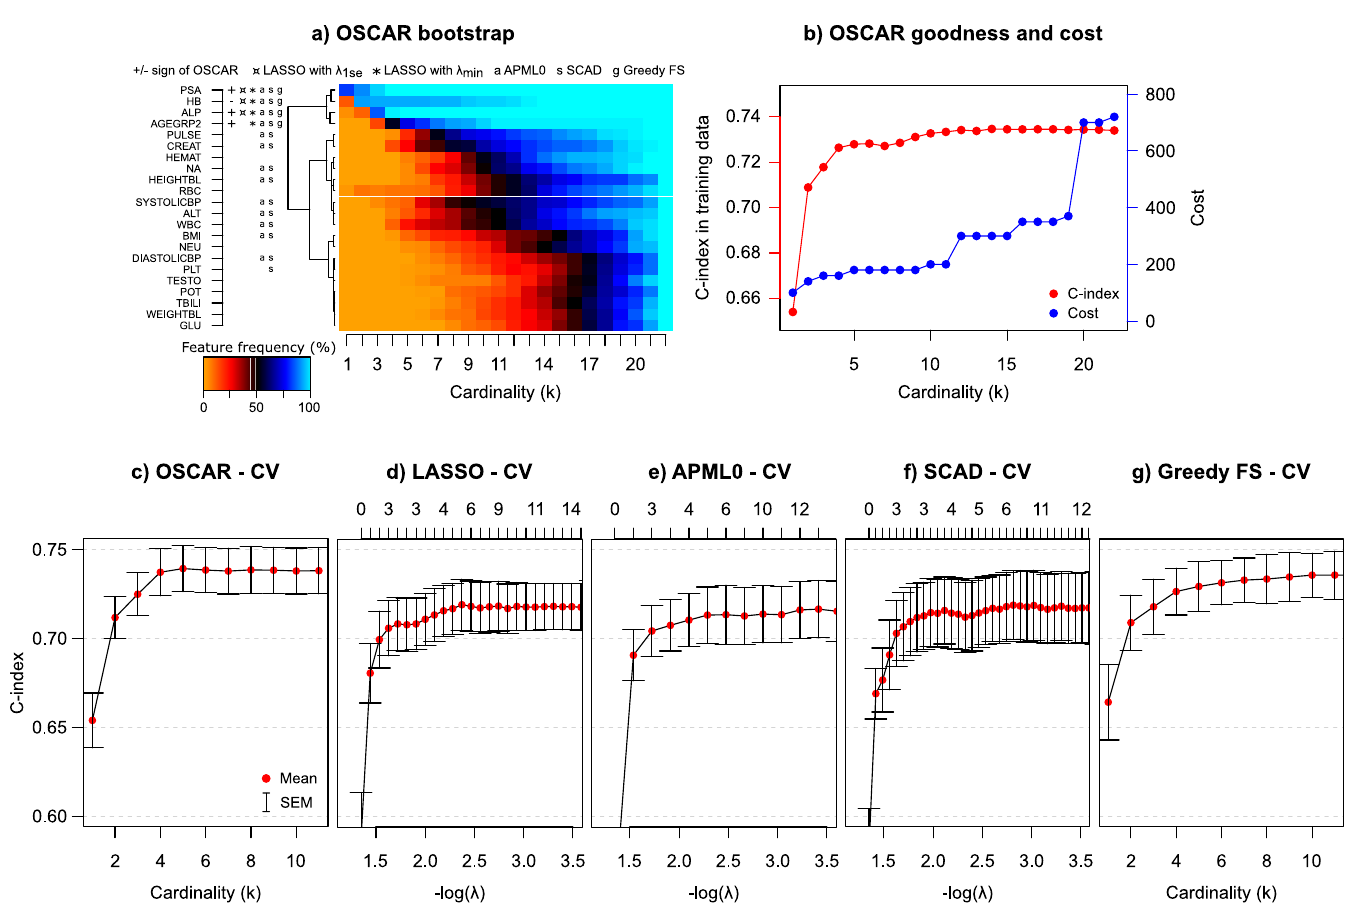
Fig 3. TYKS data: a) OSCAR BS performance. +/- denotes the sign of the coefficient in the model. Positive coefficient: higher predictor value leads towards high risk. Negative coefficient: higher predictor value leads towards low risk. ¤denotes features selected by LASSO with λ 1 denotes features selected by APM- L 0 , s denotes features selected by SCAD, g denotes features selected by Greedy FS. Color denotes how often among 100 bootstrap runs a feature is selected when a certain cardinality is set (1 meaning 100%). b) OSCAR accuracy in the TYKS training data (C-index), and cost with respect to the allowed number of predictors. Cost is calculated by kits and a kit price is added if any feature from a kit is used. c) CV performance of OSCAR. d) CV performance of LASSO. The numbers at top indicate the number of predictors selected by a specific λ . e) CV performance of APM- L 0 . f) CV performance of SCAD. g) CV performance of Greedy FS. The red dots denote the mean values and the error bars denote the standard errors of the mean (SEM) calculated over the CV folds.